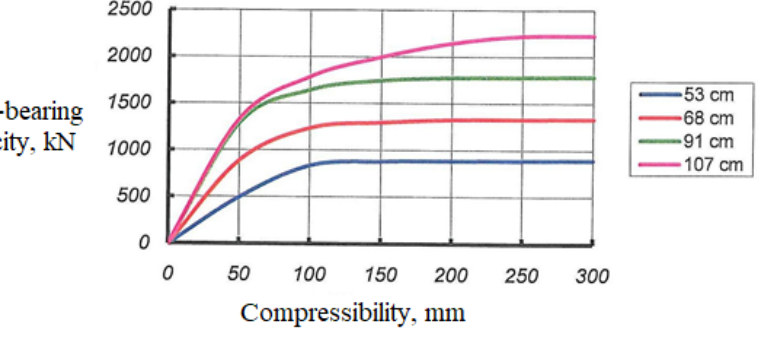
Figure 10: Load-bearing capacity of the LINK-N-LOCK box crib at the height of 2 m with different element lengths.